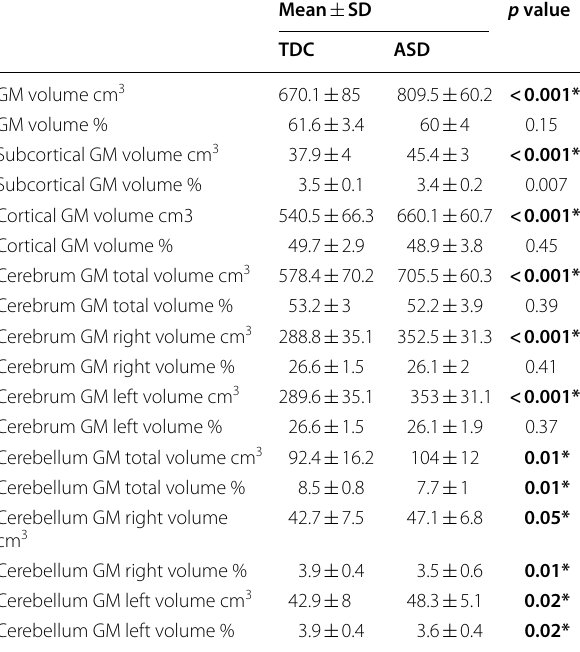
Table 5 Comparing mean volumes of different grey matter areas between TDC and ASD